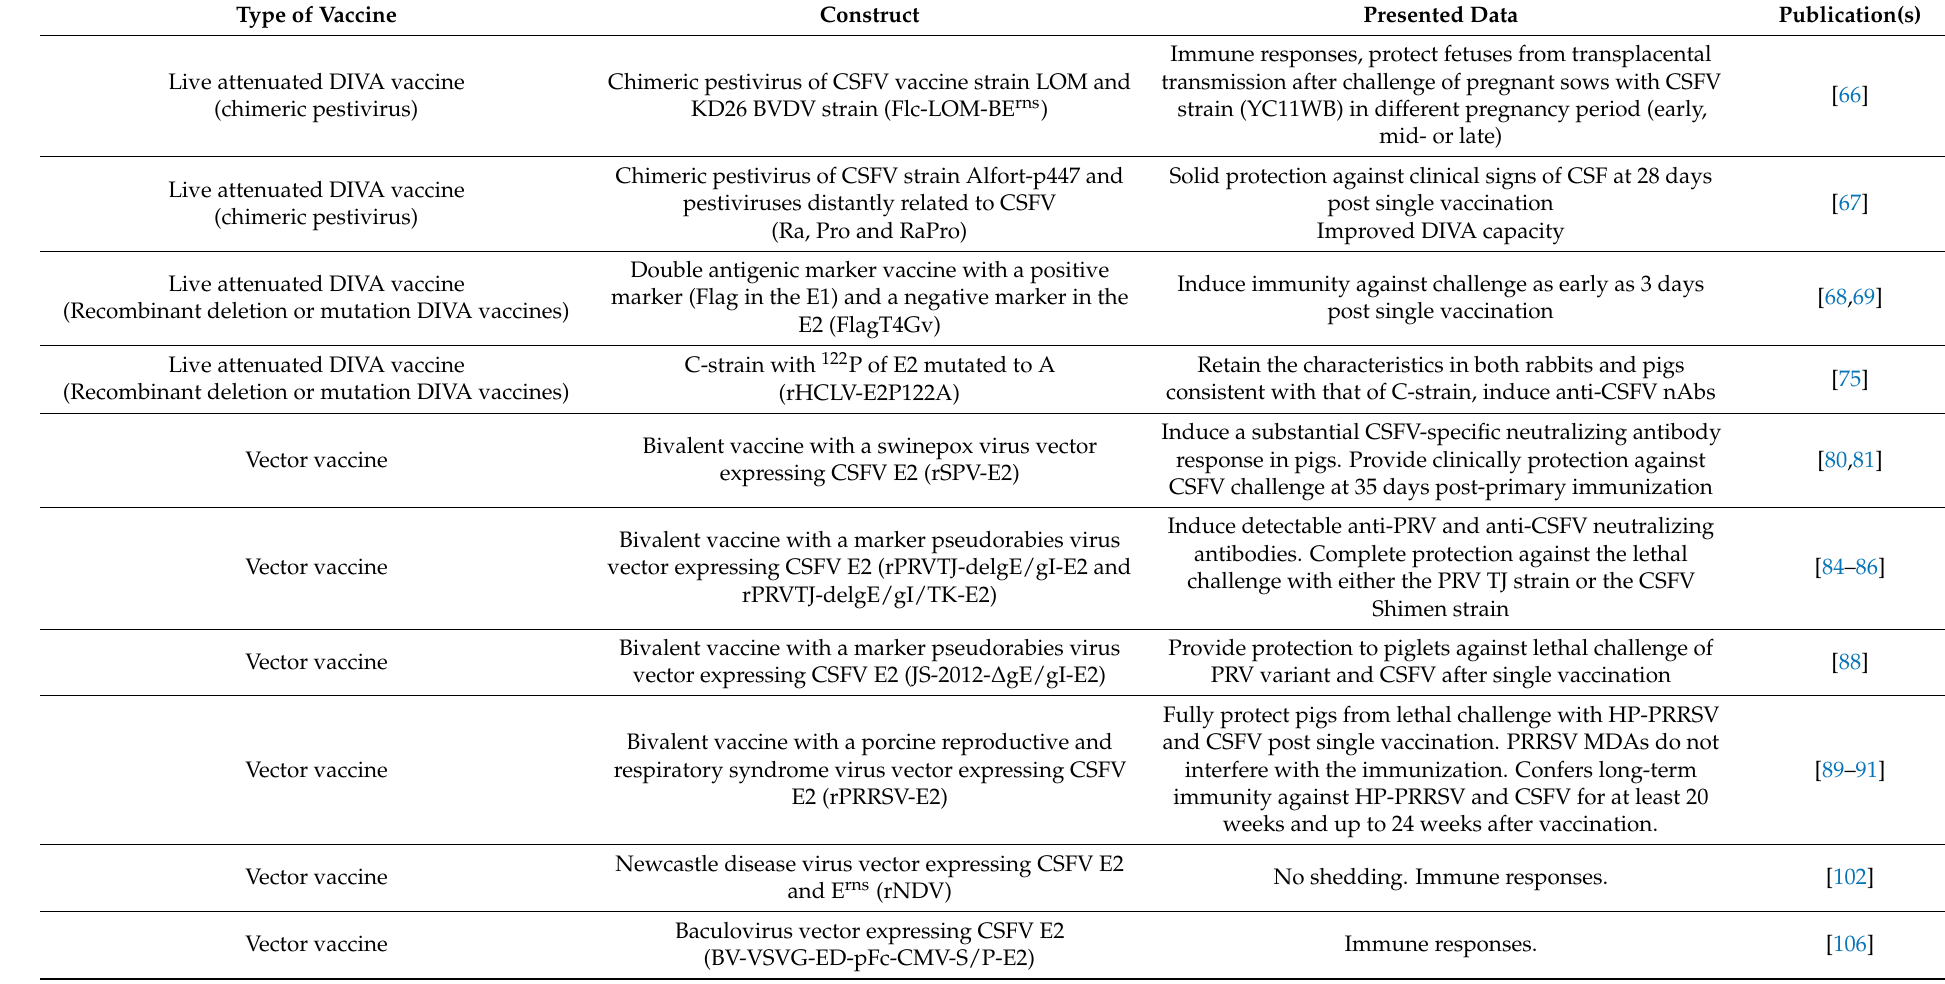
Table 1. Candidate differentiability of infected from vaccinated animals (DIVA) vaccines against Classical swine fever virus (CSFV) published in the last few